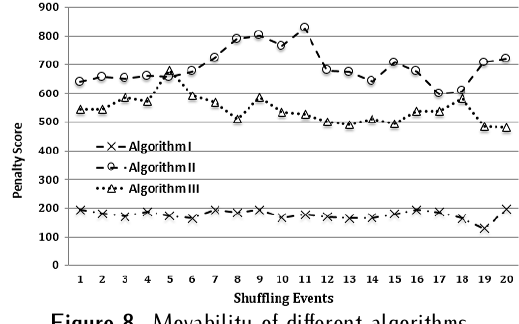
Figure 8. Movability of different algorithms